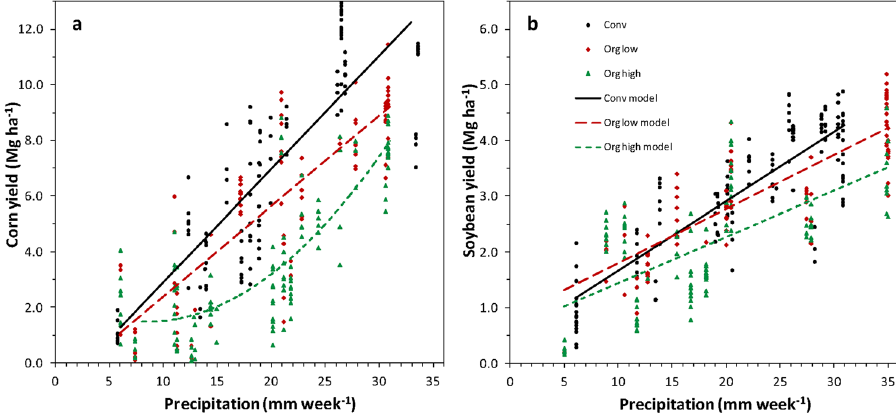
Figure 2. Yield response of ( a ) corn and ( b ) soybean to precipitation during the most beneficial period. Regressions were computed for conventional systems (Conv), organic systems with weed cover < 25% (Org low), or organic systems with weed cover ≥ 25% (Org high). Corn models were Y = 0.408X − 1.183 (R 2 = 0.71, n = 112) for Conv, Y = 0.326X − 0.863 (R 2 = 0.70, n = 85) for Org low, and Y = 0.0128X 2 − 0.215X + 2.83 (R 2 = 0.68, n = 117) for Org high, where Y = yield and X = weekly precipitation. Soybean models